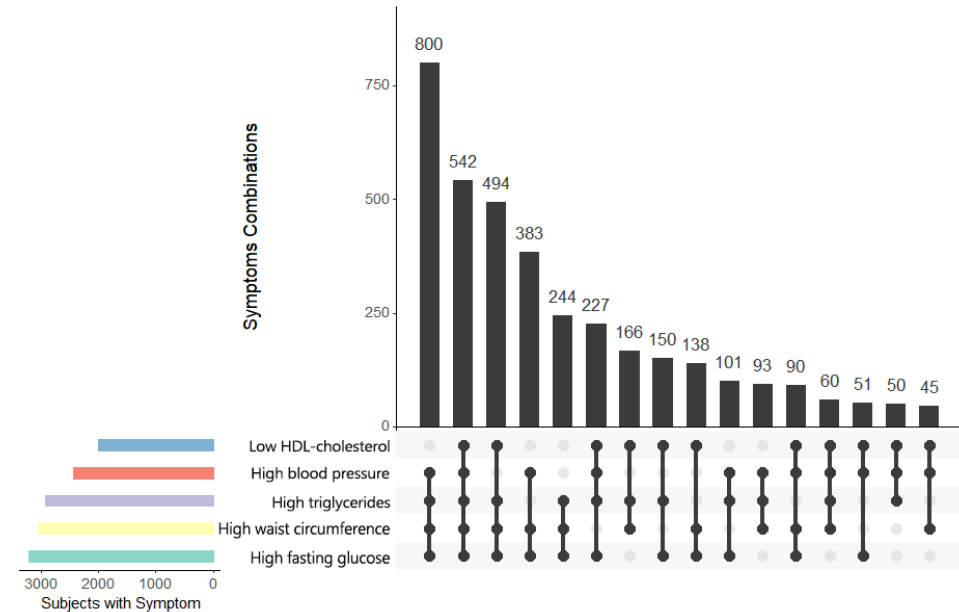
Figure 1. Frequencies of MetS components and their combinations among US adults ≥ 20 years with metabolic syndrome. Vertical bars in the main plot at top right are frequencies of subjects. Below each vertical bar is a line linking solid dots, indicating the concurrence of MetS components reflected by the bar above. Horizontal bars at bottom left indicate the frequencies of each individual MetS component.